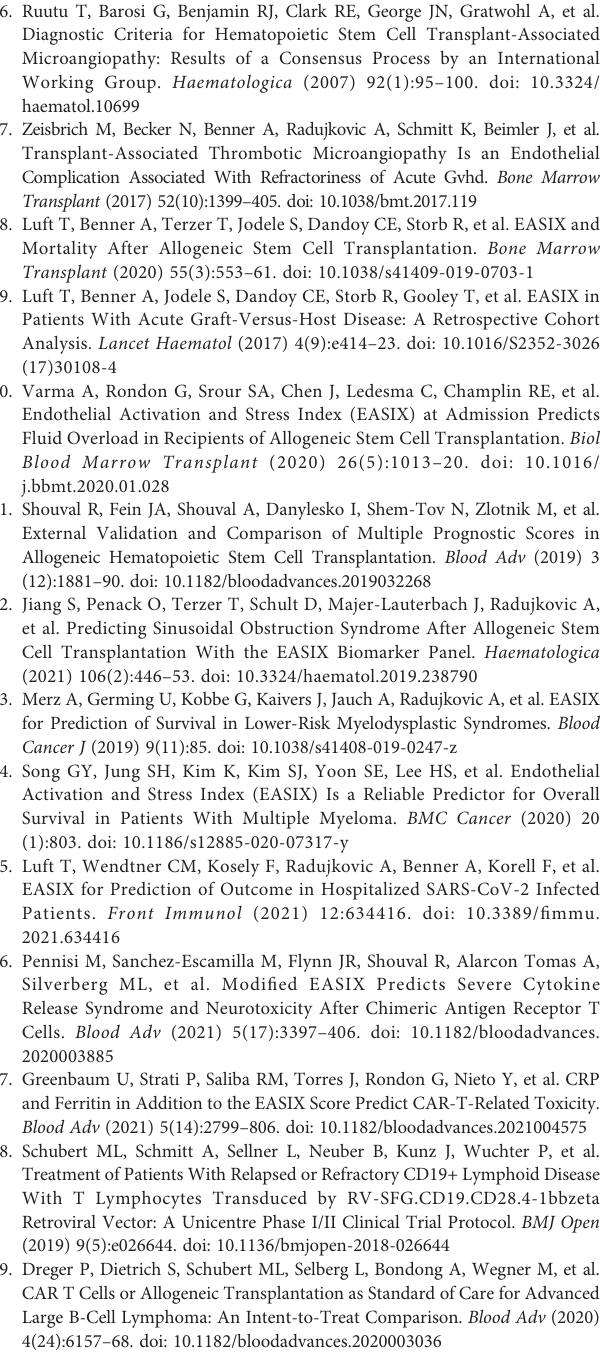
Supplementary Figure 4 | Asymptotic Generalized Maximally Selected Statistics. We applied maximally selected statistics in order to investigate